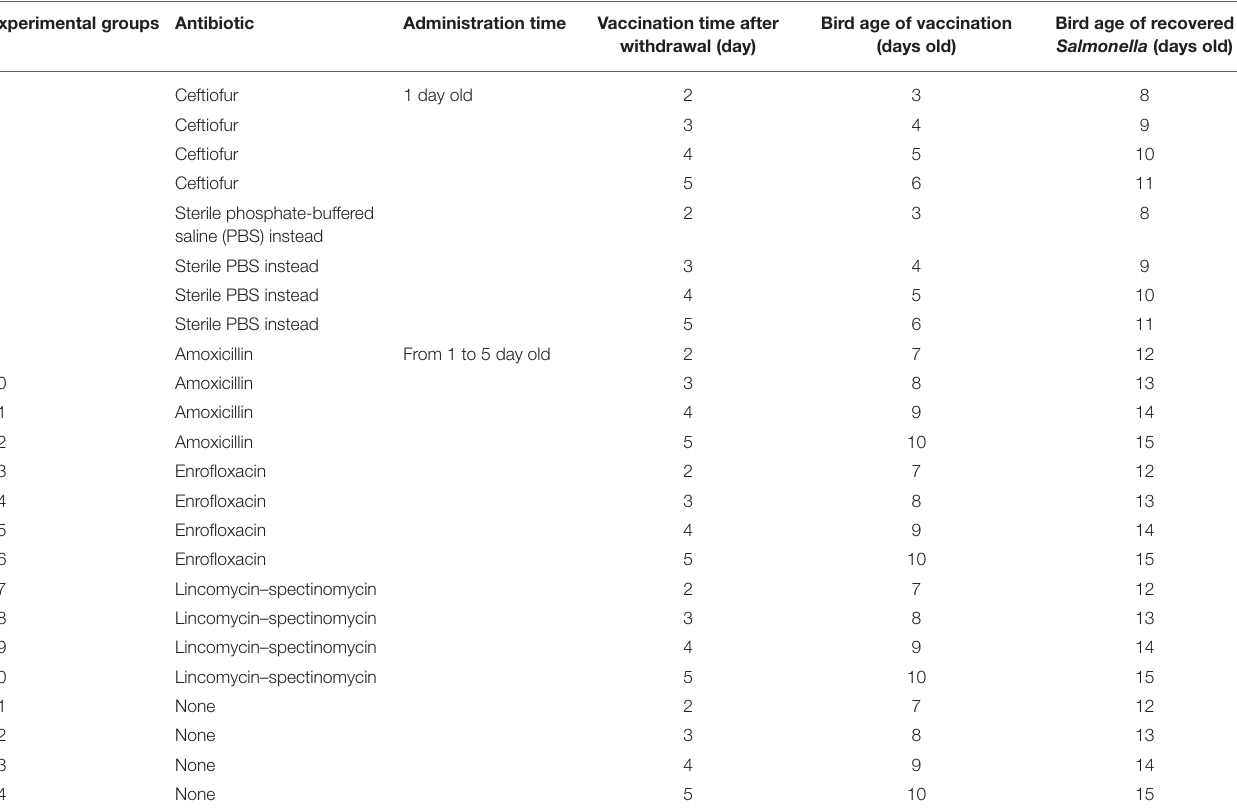
TABLE 1 | Experimental design. Experimental groups Antibiotic Administration